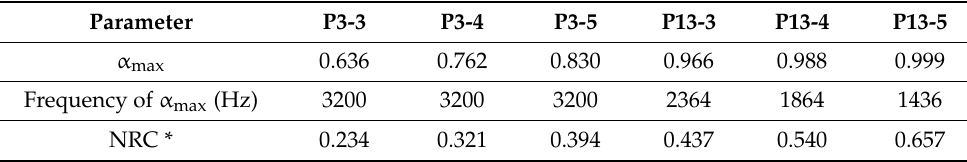
Table 5. Maximum sound absorption coefficient ( α max ), frequency corresponding to the maximum sound absorption, and the noise reduction coefficient (NRC) for the tested samples.